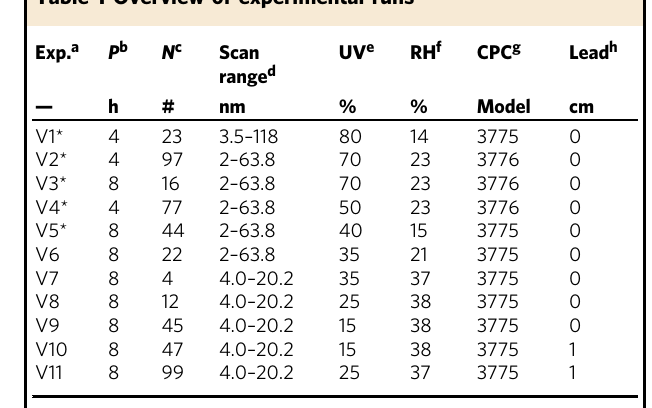
Fig. 8 Example of d N tot ð d ; t Þ = N ð d Þh ið Þ = d t ð Þ 2 , normalized with this functions maximum value at diameter d , in the ( d , t )-plane. From experiment V9. The black dashed line and red lines are the maximum values, found from a Gaussian fi t, and determine the evolution of the pro fi les 1 and